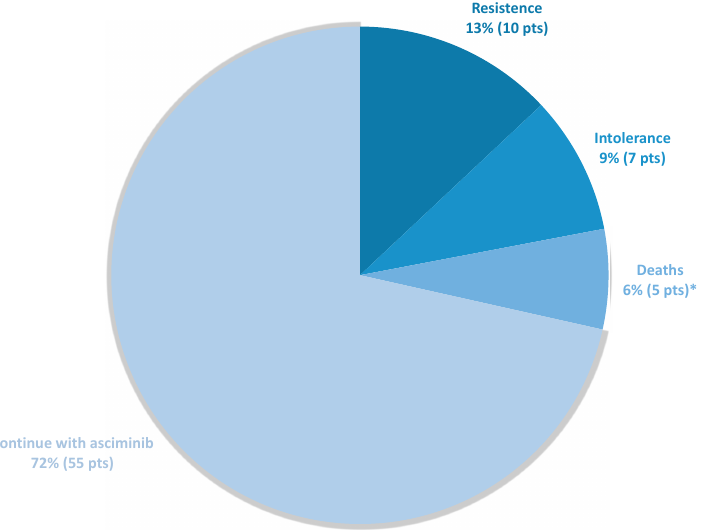
Figure 1. Discontinuations of asciminib divided by cause at the end of the follow-up period. Pts, patients. * Causes of deaths: pharyngeal neoplasm, hepatic adenocarcinoma, skin ulcer with calci- phylaxis, and two unknown causes